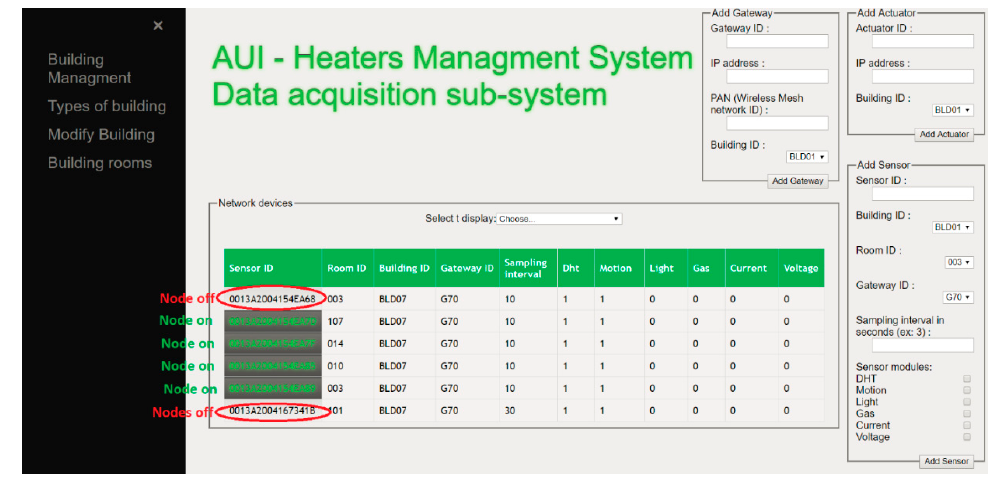
Figure A1. WSN nodes displayed on the web application.